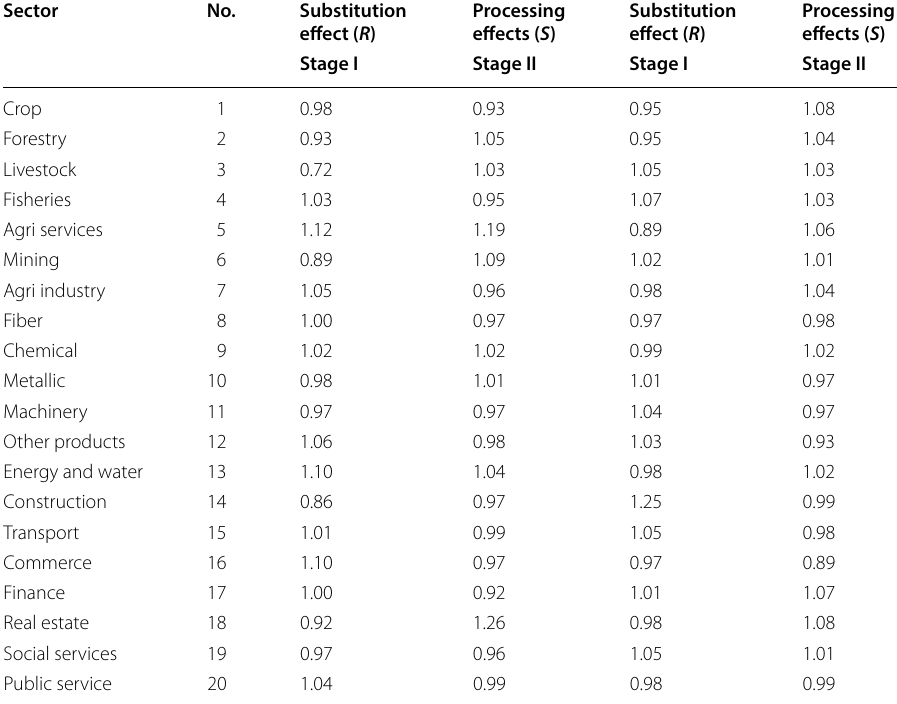
Table 6 Relative growth potential of each industry (RAS analysis) Sector